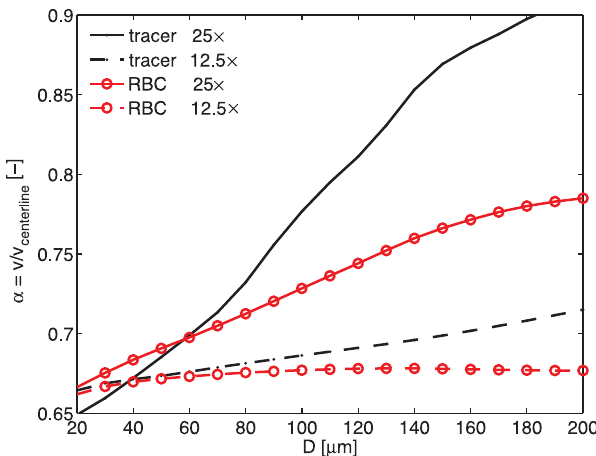
Figure 8. Model prediction for underestimation. Predicted underestimation of the measured velocity (compared to the true centerline velocity) as a function of blood vessel diameter, based on the ‘in silico’ PIV